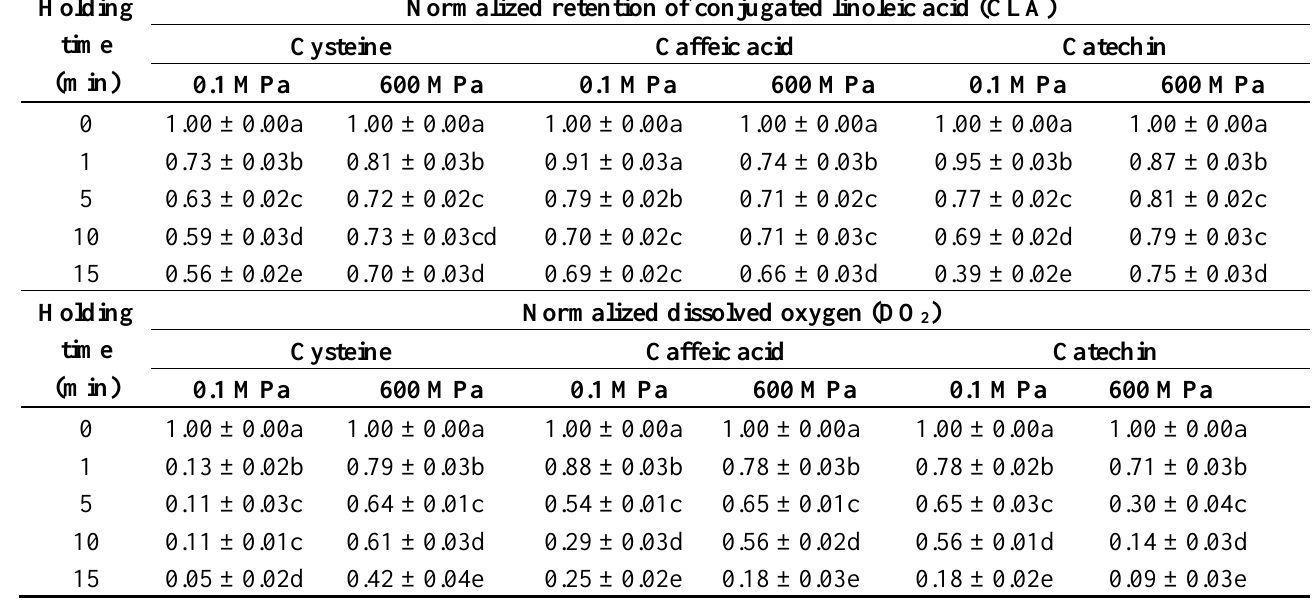
Table 2. Changes in conjugated linoleic acid (CLA) and dissolved oxygen (DO 2 ) in CLA-enriched milk added with either cysteine, caffeic acid or catechin and treated at 120 °C and 0.1 or 600